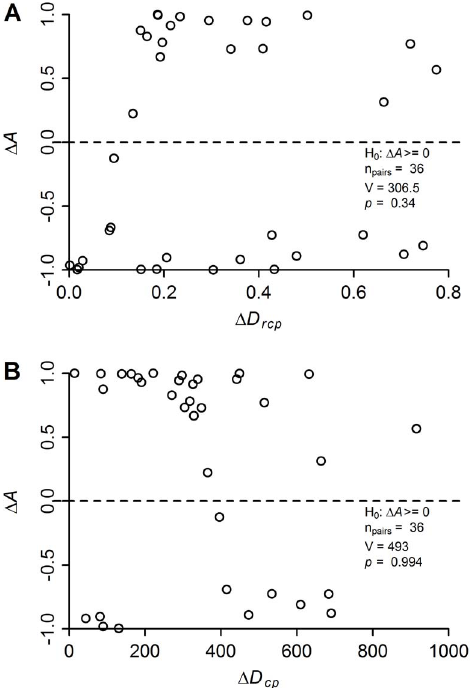
Figure 6. Correlation between differences in species’ abun- dances ( D A ) and differences in distances from their range centers. Panel A uses relative distances from species’ range centers ( D D rcp ), and panel B absolute distances ( D D cp ).